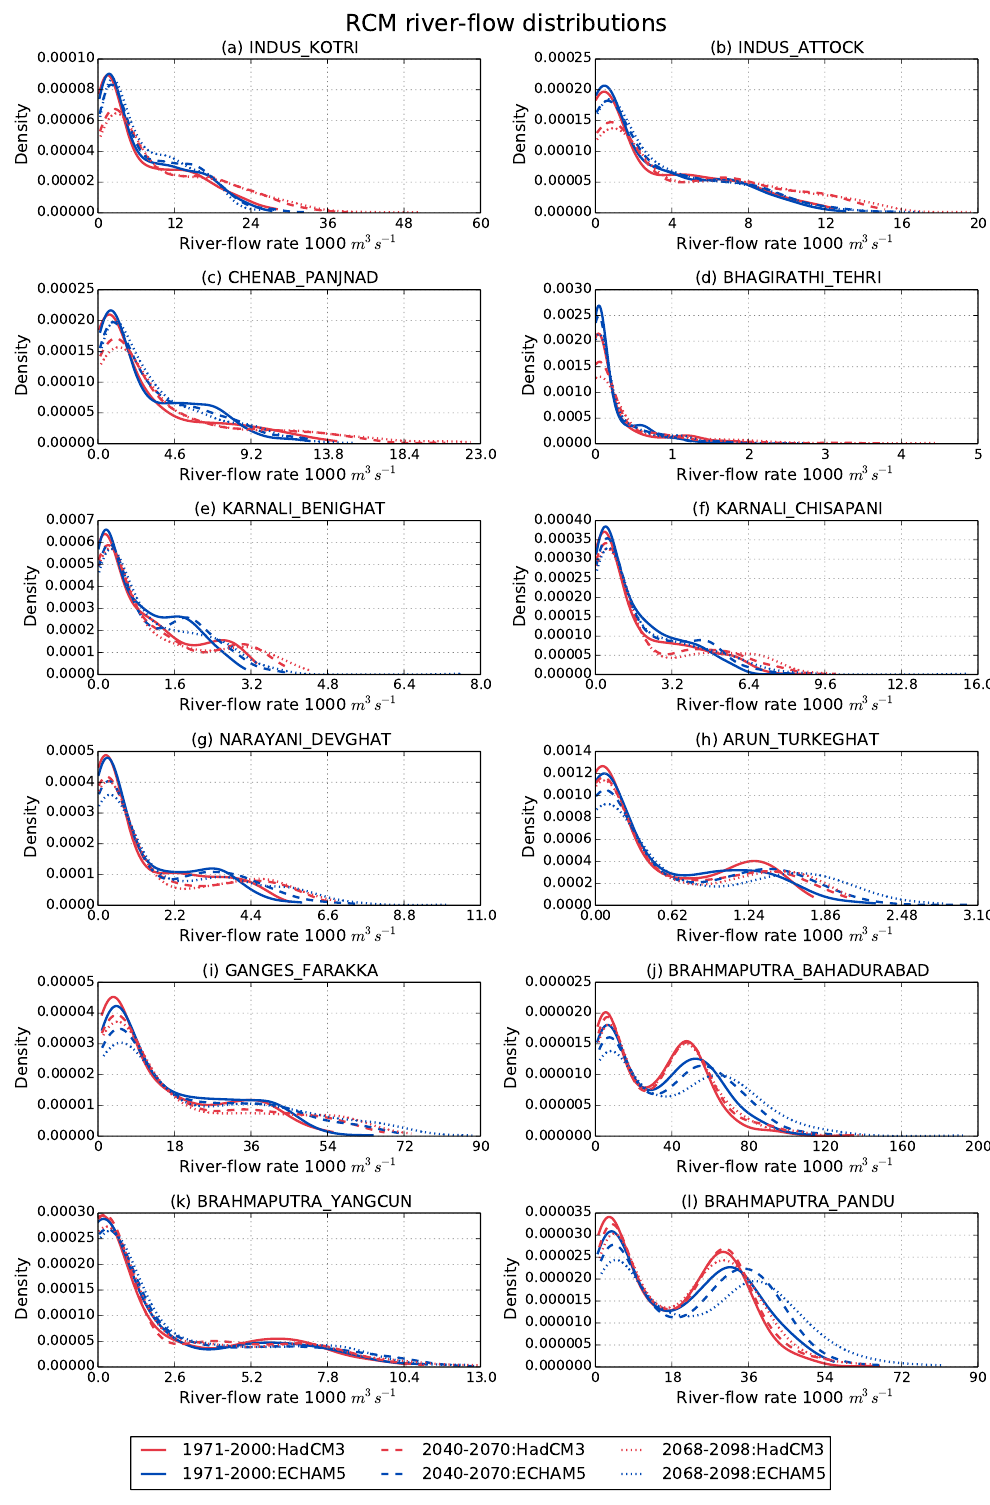
Figure 11. The distribution of the river flow in the HadCM3 and ECHAM5 (HadCM3 – red, ECHAM5 – blue) runs for three periods: historical (1971–2000 – solid lines) and two future periods (2050s – dashed lines and 2080s – dotted lines) plotted as a pdf for each river